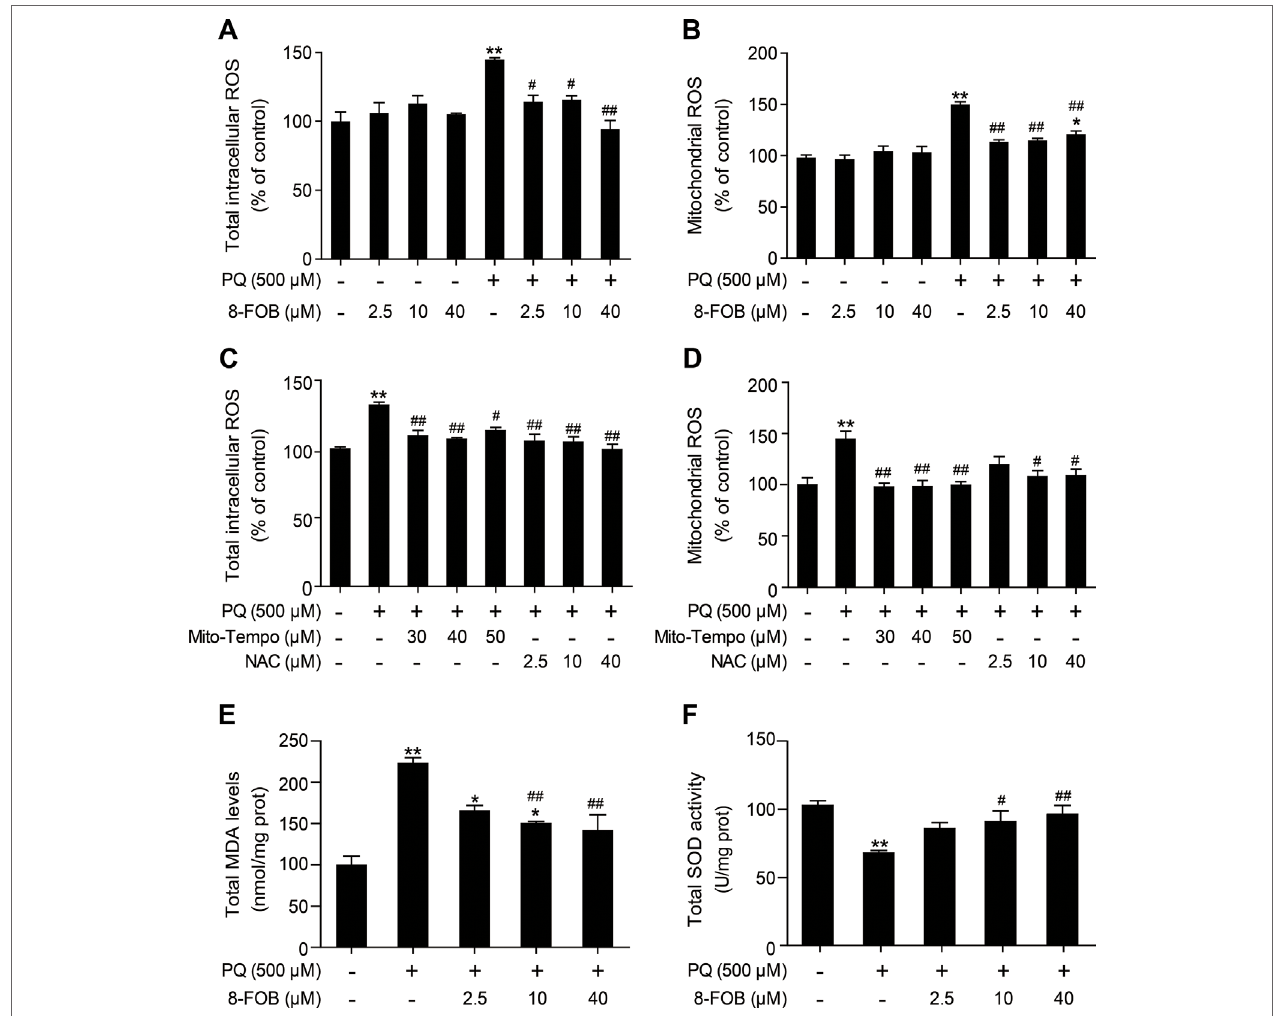
FIgURe 3 | 8-Formylophiopogonanone B (8-FOB) reduces paraquat (PQ)-induced oxidative stress in L02 cells. Total intracellular reactive oxygen species (ROS) (A, C) and mitochondrial ROS (B, D) were detected 3 h after PQ treatment in L02 cells. The total malondialdehyde (MDA) level (e) and superoxide dismutase (SOD) activity (F) were measured 24 h after PQ treatment. The values are presented as the means ± SEM ( n = 6). * p < 0.05, ** p < 0.01 vs the control group; # p < 0.05, ## p < 0.01 vs the PQ group.